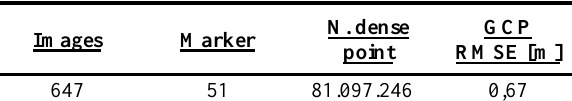
Table 1. Characteristics of the obtained point cloud of Via San Polo